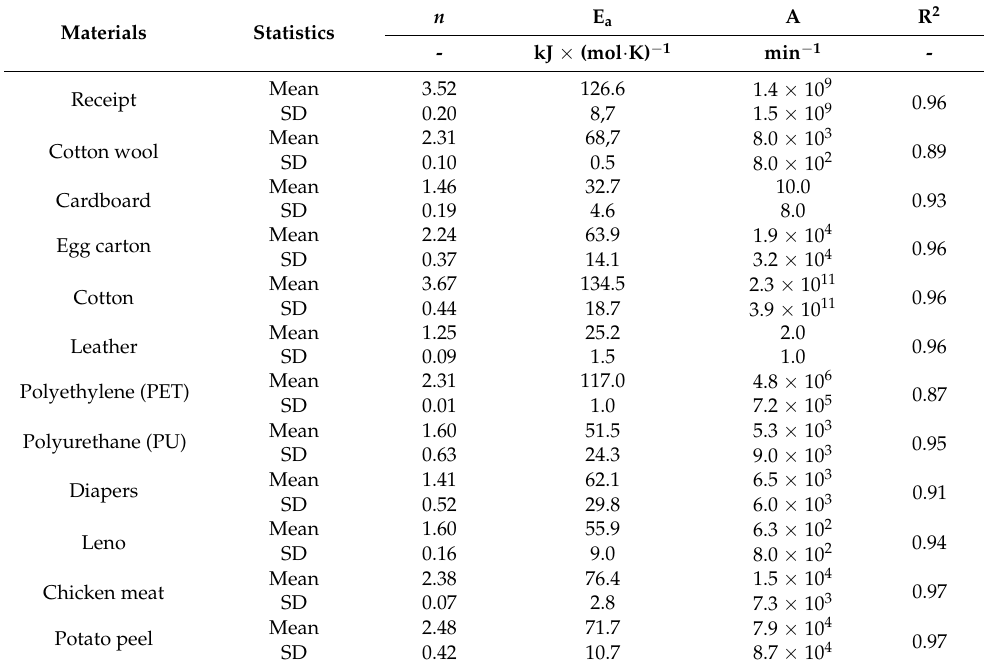
Table 2. Kinetics analysis of research materials for β = 5 K · min − 1